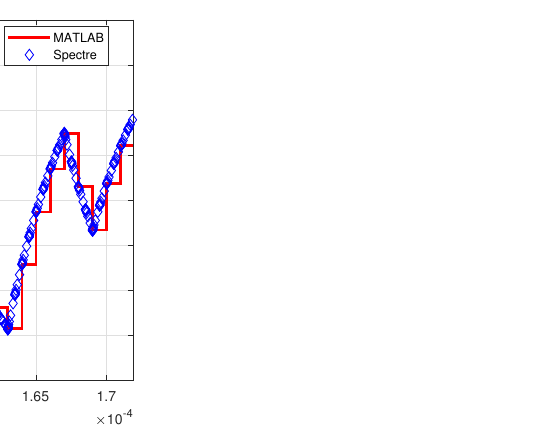
Figure 12. Comparison of AFE output voltages from theoretical (MATLAB) and circuit-level (SPEC- TRE) simulations.